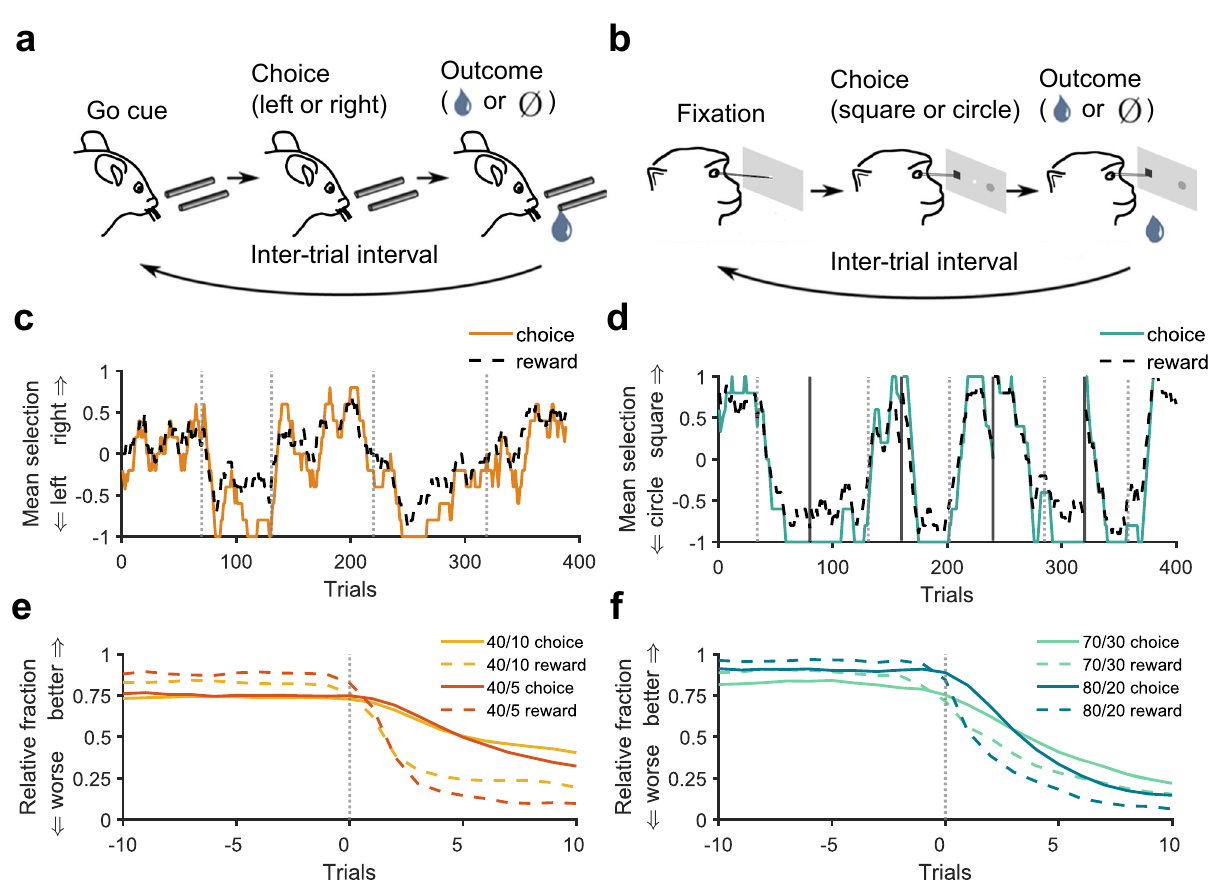
Fig. 1 Schematic of the experimental paradigms in mice and monkeys and basic behavioral results. a , b Timeline of a single trial during experiments in mice ( a ) and monkeys ( b ). To initiate a trial, mice received an olfactory go cue (or no-go cue in 5% of trials) ( a ), and monkeys fi xated on a central point ( b ). Next, animals chose (via licks for mice and saccades for monkeys) between two options (left or right tubes for mice and circle or square for monkeys) and then received a reward (drop of water and juice for mice and monkeys, respectively) probabilistically based on their choice. c , d Average choice and reward using a sliding window with a length of 10 for a representative session in mice ( c ) and fi ve superblocks of a representative session in monkeys ( d ). Mean selection of 1 and − 1 correspond to 100% selection of or 100% reward on the right and left in mice (square and circle stimuli in monkeys), respectively, and mean selection of 0 corresponds to equal selection or reward on the two choice options. Vertical gray dashed lines indicate trials where reward probabilities reversed. Vertical gray solid lines indicate divisions between superblocks in the monkey experiment. e , f Average relative choice and reward fractions around block switches using a non-causal smoothing kernel with a length of three separately for all blocks with a given reward schedule in mice ( e ) and monkeys ( f ). The better (or worse) option is the better (or worse) option prior to the block switch. Trial zero is the fi rst trial with the reversed reward probabilities. Average choice fractions for the better option (better side or stimulus) are lower than average reward fractions for that